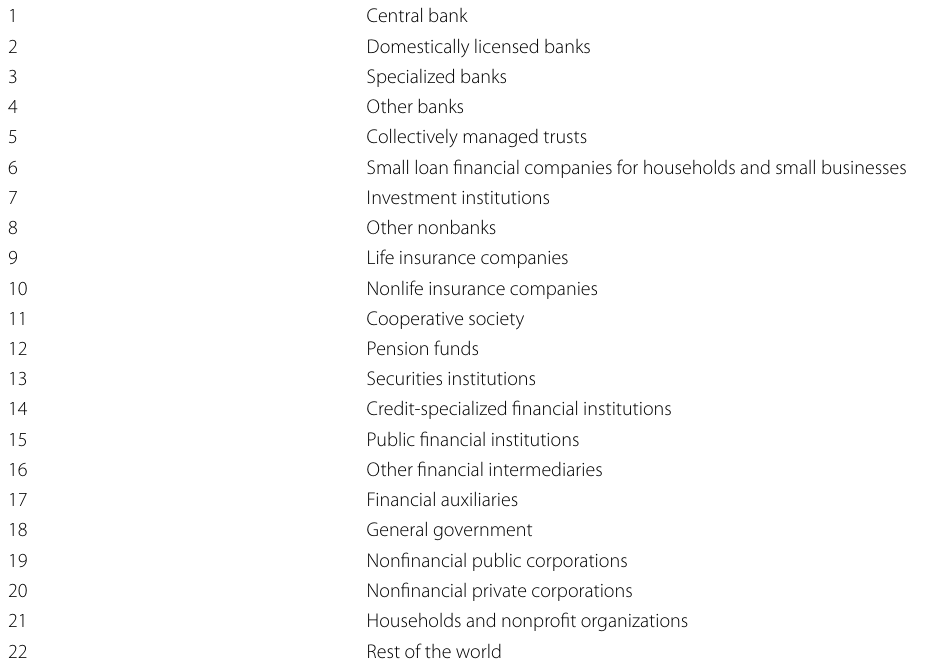
Table 3 Institutional sectors in the FOF